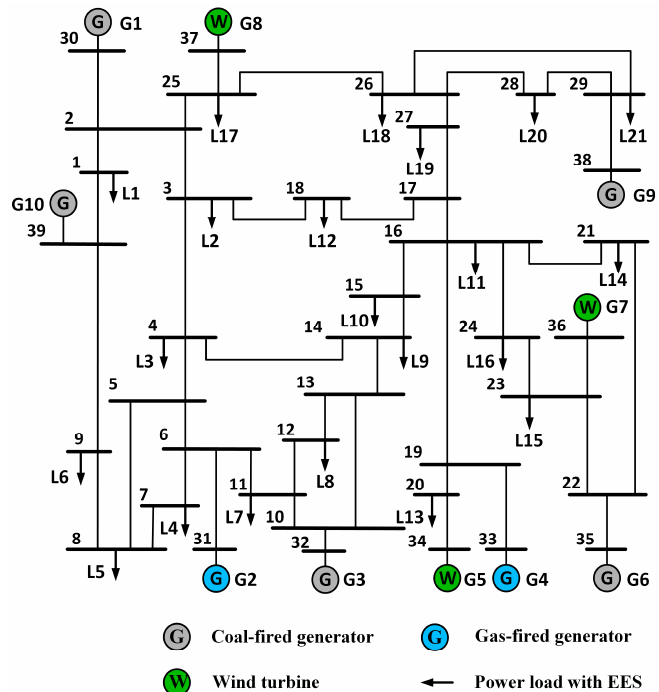
Figure 2. The modified New England 39-bus test system.